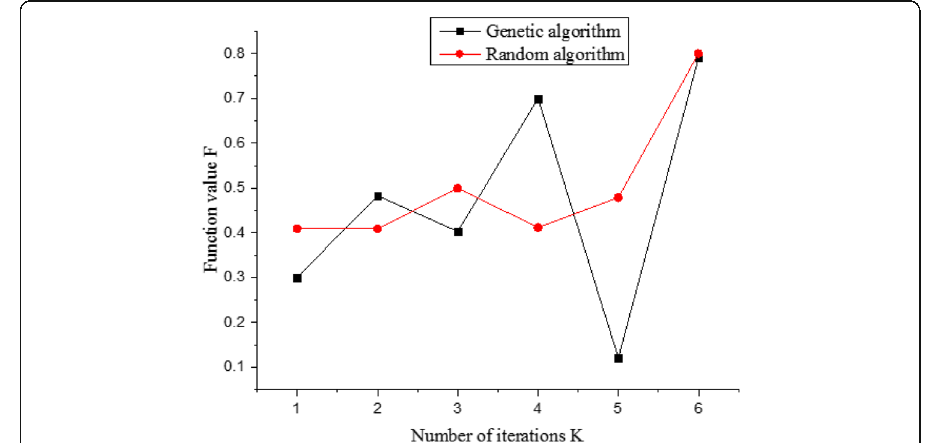
Fig. 7 Two algorithm contrastive convergent